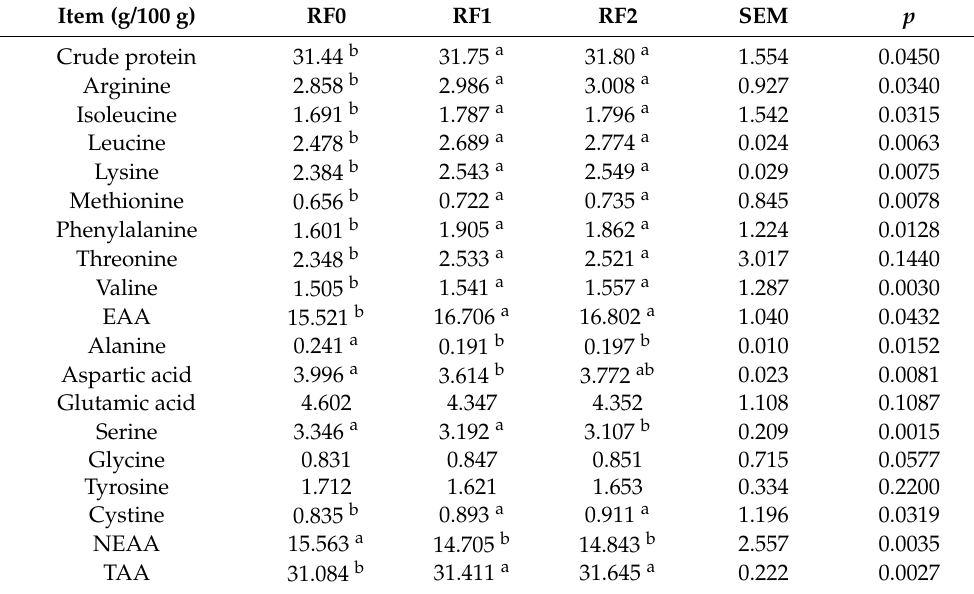
Table 4. Crude protein concentration and AA profile in fresh egg yolks. Item (g/100 g)